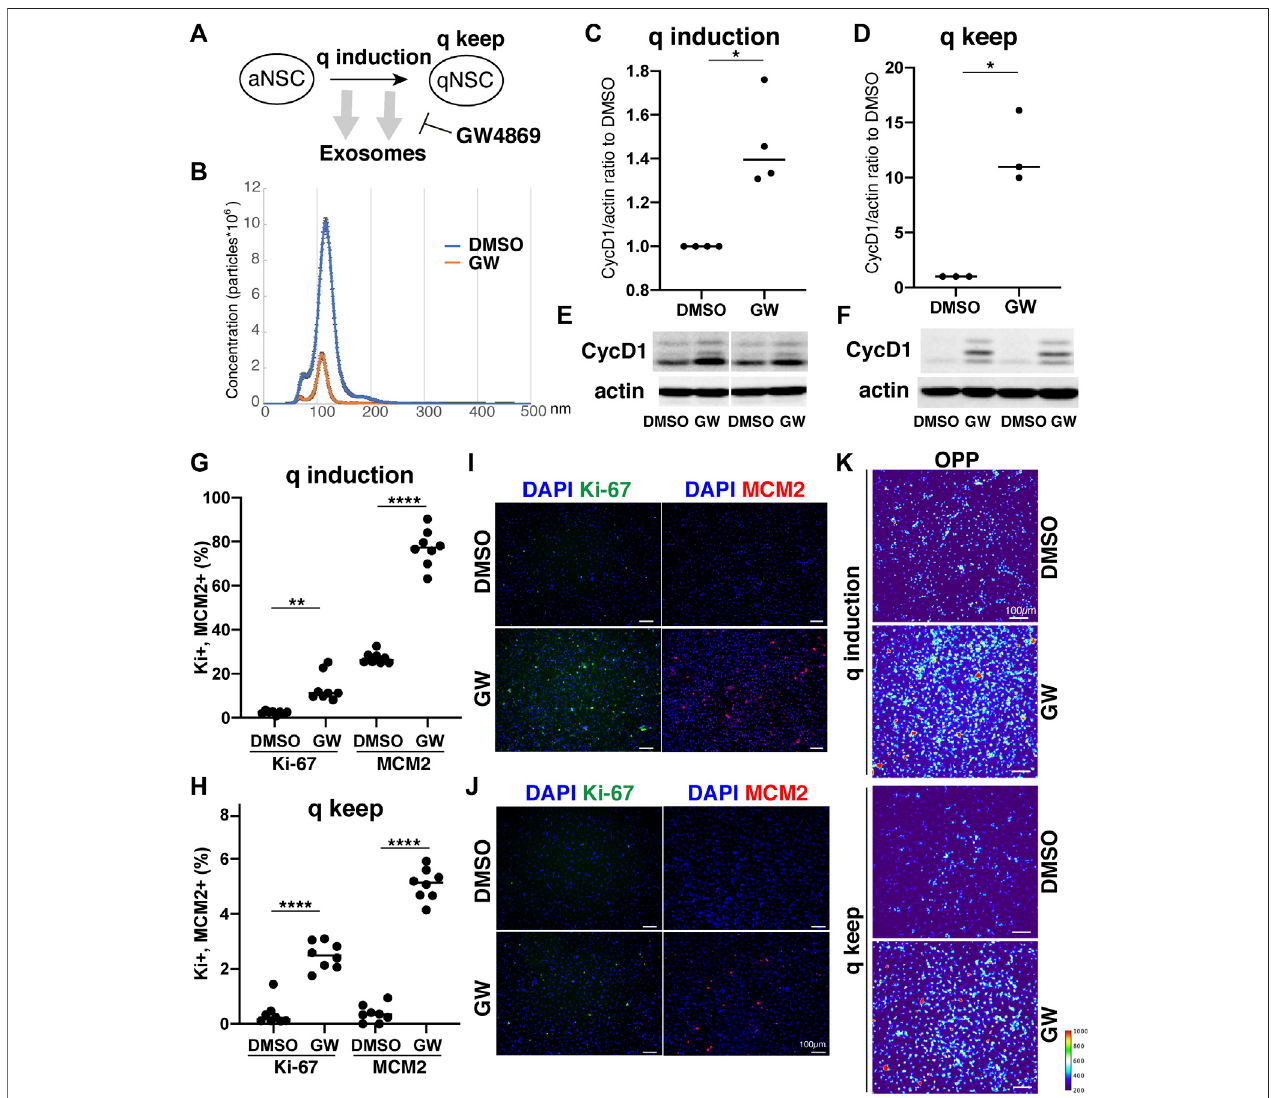
FIGURE 4 | Exosomes involved in cell cycle regulation of qNSCs. (A) Exosomal functions in quiescence entrance and maintenance. (B) Exosome quanti fi cation of aNSCs after treatment with GW4869 (orange) and DMSO as a control (blue). Horizontal axis: vesicle size. Vertical axis: vesicle number. (C,D) Quanti fi cation of CycD1 levels in NSCs after inducing (C) and maintaining quiescence (D) in presence of GW4869 for 12 h (C) and 24 h (D) . All values were divided by that for DMSO control. Each plot indicates independent experiments. CycD1 band intensities were divided by those of actin bands. Ratios with respect to DMSO control are plotted. Middle lines in plots are medians. (* p < 0.05, **p < 0.01; two-tailed paired t-test, n (cid:2) 4; For q-keep, one outlier identi fi ed by outlier test of Grubbs was removed). (E,F) Representative results of WB of quiescence induction (E) and maintenance (F) . CycD1 were three bands, and actin is loading control. (G,H) Cell counts of Ki-67- and MCM2-positive cells after inducing (G) and maintaining quiescence (H) after incubation with GW4869 for 24 h. Ki-67-and MCM2-positive cell numbers were divided by the cell number based on DAPI staining and shown as the percentage. (** p (cid:2) 0.013, ****p < 0.0001; one-way ANOVA, Turkey ’ s multiple comparison test, n (cid:2) 8). (I,J) Representative photos of Ki-67- (green) and MCM2-positive cells (red) with DAPI staining (blue) in panel G (I) and H (J) . (K) Protein synthesis activity in the quiescence- induced (q induction) and maintained cells (q keep). The intensity of OP-puro labeling (OPP) is represented by a thermal scale.